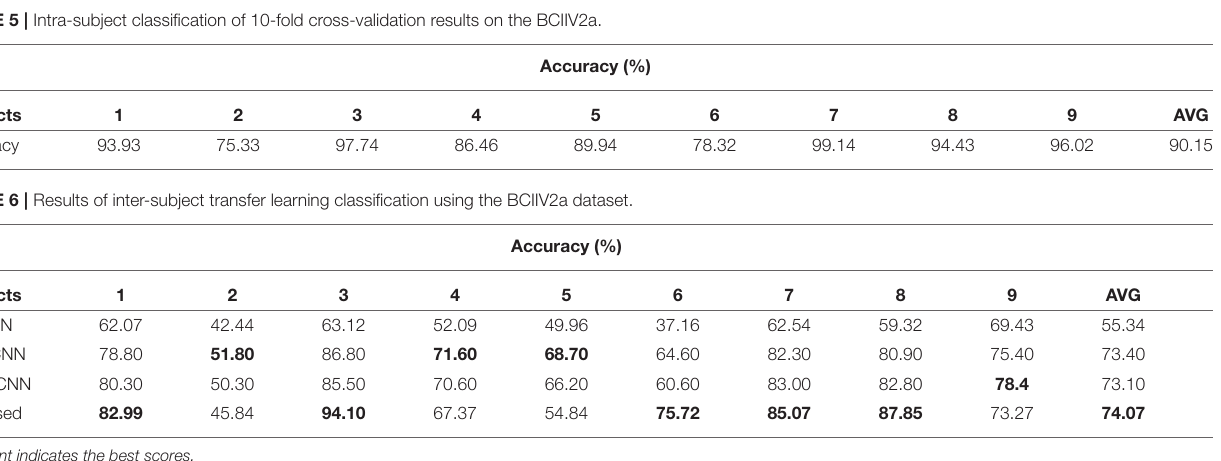
TABLE 5 | Intra-subject classification of 10-fold cross-validation results on the BCIIV2a.